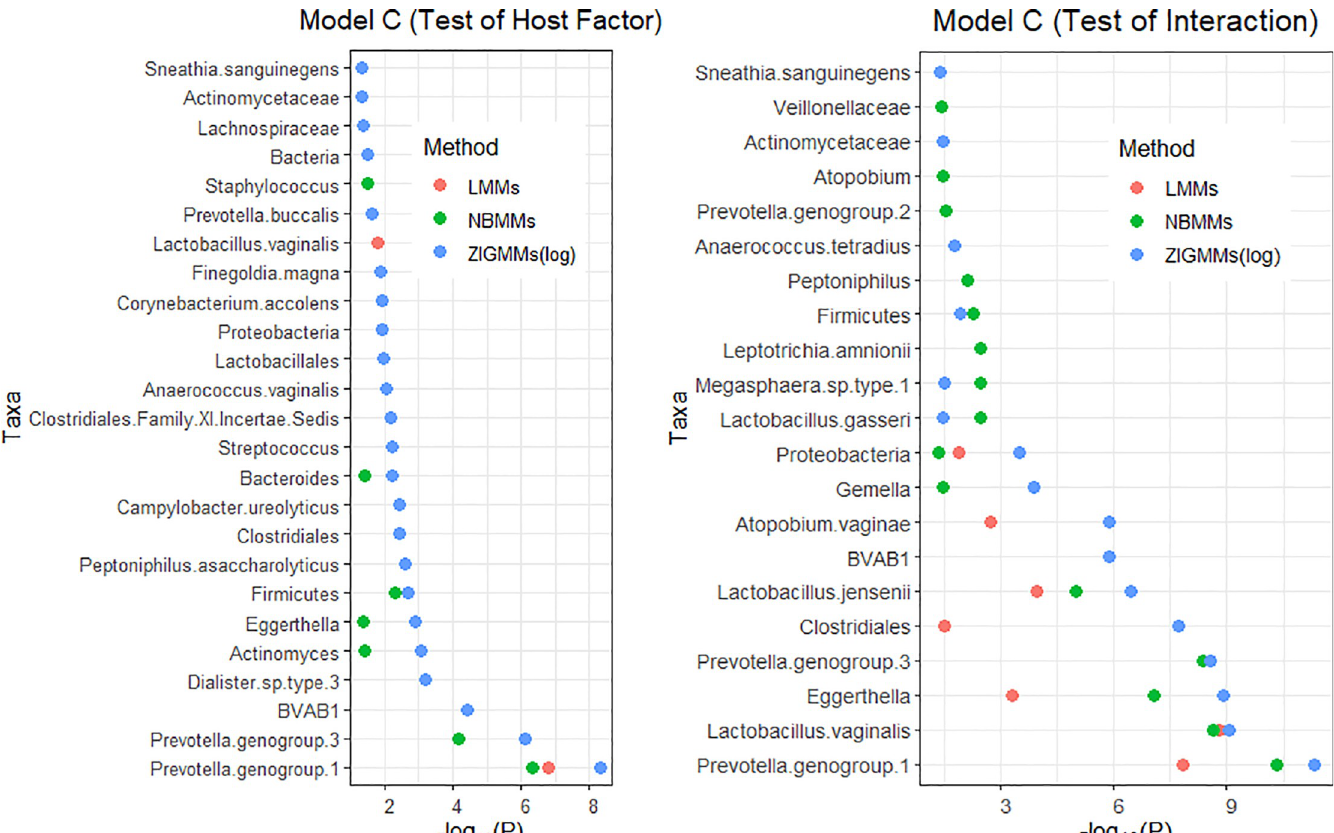
Fig 3. The analyses of ZIGMMs(log), NBMMs and LMMs: minus log transformed p-values for the significant differentially abundant taxa at the 5% significance threshold between pregnancy and non-pregnancy groups for host factor effect (left panel) and interaction effect (right panel) from Model